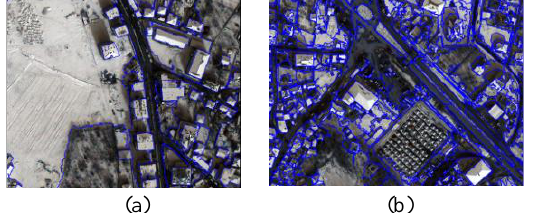
Figure 3: Image segmentation in the (a) homogenous, (b) heterogeneous area.